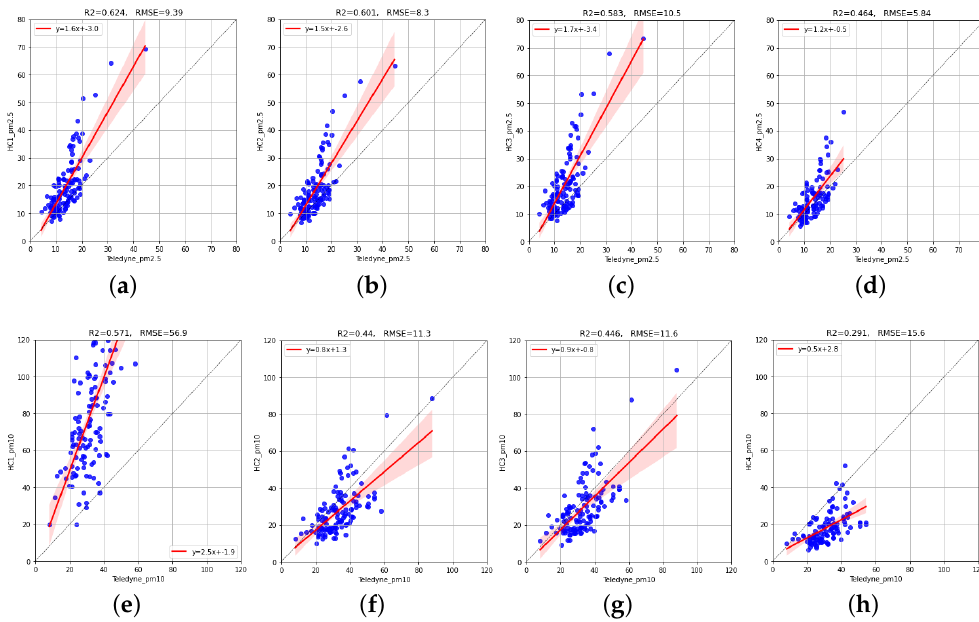
Figure 4. Scatterplots of the reference (Teledyne) vs. IQAir hourly measurements in the Test period. The top row shows results for the PM 2.5 sensors. The bottom row shows results for the PM 10 sensors. The red line represents the linear regression function between candidate sensor values and reference sensor values adjusted with data from the Train period: ( a ) HC1 ( PM 2.5 ); ( b ) HC2 ( PM 2.5 ); ( c ) HC3